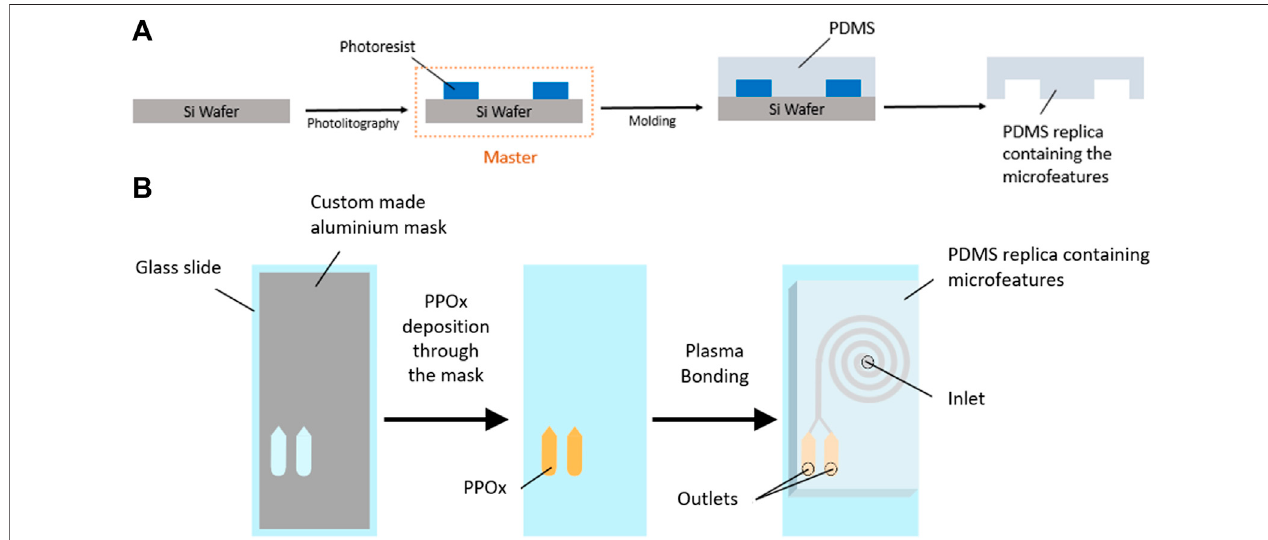
FIGURE 2 | Schematic diagram of SU-8 master fabrication and PDMS molding (A) and PPOx deposition and device assembly (B)